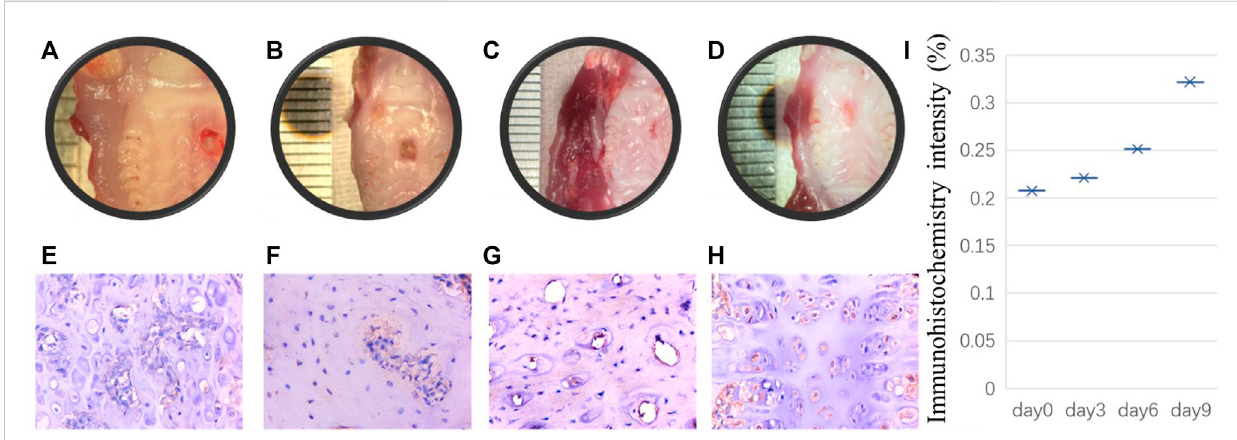
FIGURE 1 Initialresultsperformedbyourresearchgroup:Apunchwoundwithadiameterof2 mmwascreatedonthepalateof8-week-oldrats.Theratswere sacri fi ced euthanized on the day of modeling, the third day, the sixth day and the ninth day after modeling respectively. Tissue samples were collected from thewound site on theday of rats sacri fi ced.After decalci fi cation, the samples were embedded inparaf fi n, and theparaf fi nsectionswere stained for immunohistochemistry.Thehistologicalmanifestationswereobservedandanalyzed. (A – D) showsthatpunchwoundhealingprocessfromday0,3, 6, 9 respectively. Correspondingly, for immunohistochemistry staining, (E – H) indicates Prx1-expressing cells in bone tissue around the defect area